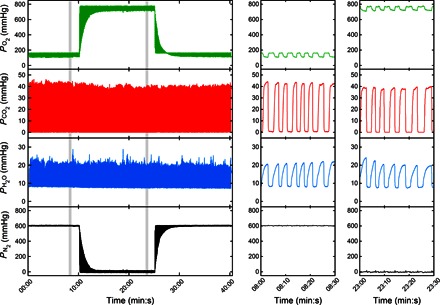
Partial pressures for the airway gases during an O2 wash-in and wash-out experiment.A volunteer was initially asked to breathe laboratory air flowing pass the exhaust side of the MFS through a Y-piece connector. The gas mixture was delivered at approximately 100 liters/min to ensure that no rebreathing of expired gas would take place. After 10 min of stable breathing, the inspired gas was switched from air to medical-grade O2 (>99.5%). Approximately 15 min were allowed for the nitrogen to be fully washed out from the lungs, and then the gas supply was switched back to air. Right panels show expanded versions of the data at times indicated in the main panel to illustrate intrabreath morphology.